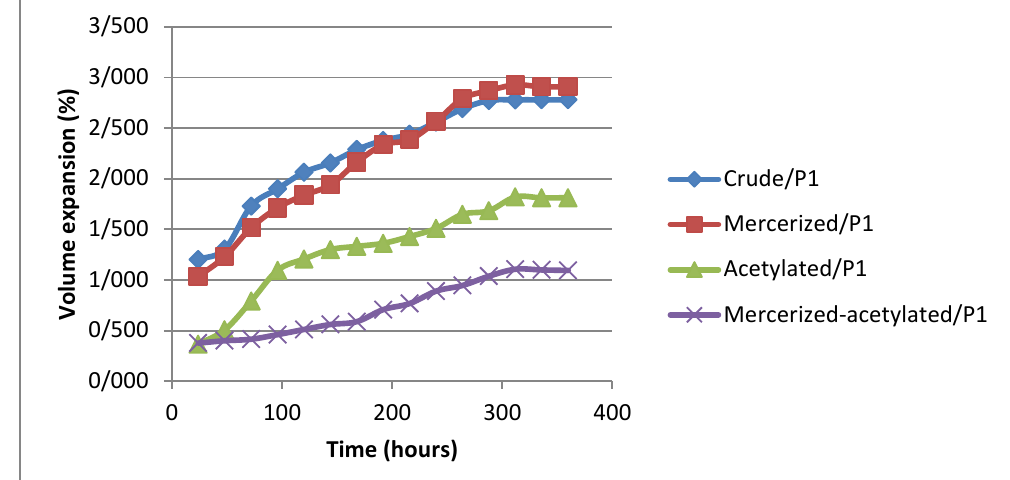
Fig. 18. Volume expansion due to moisture absorption at P1 fibre content .